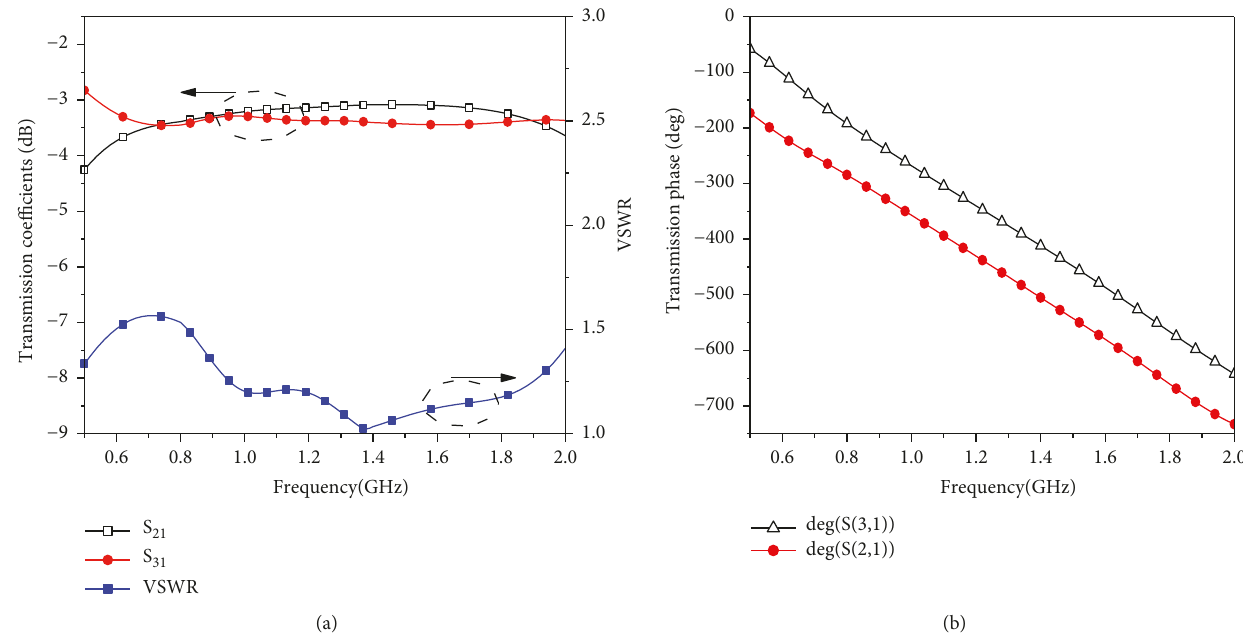
Figure 2: Performance of feed network. (a) Transmission coe ffi cients and VSWR. (b) Transmission